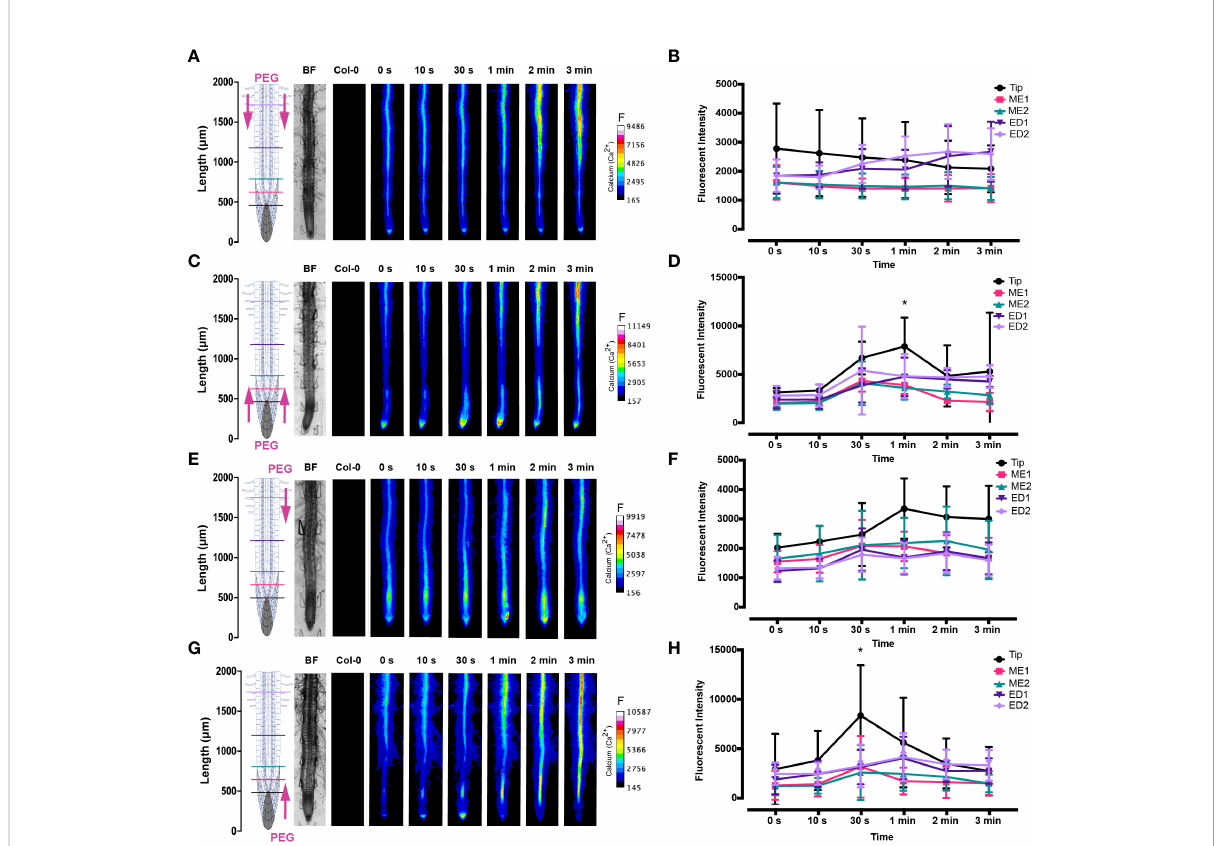
FIGURE 5 Fluorescence intensity of Ca 2+ in Arabidopsis G-CaMP3 roots exposed to PEG (20%). Fluorescence was observed for 180 s post PEG treatment. (A) Heat map view depicting Ca 2+ release, corresponding to increase in G-CaMP3 fl uorescence. Five linear sections used for fl uorescence quanti fi cation upon targeted application of PEG treatment through inlets A (left) & B (right) at the differentiation zone (DZ) are shown (n= 5). Colour change indicates an increase in Ca 2+ fl uorescence. Root schematic depicting treatment application, orientation (Polyethylene